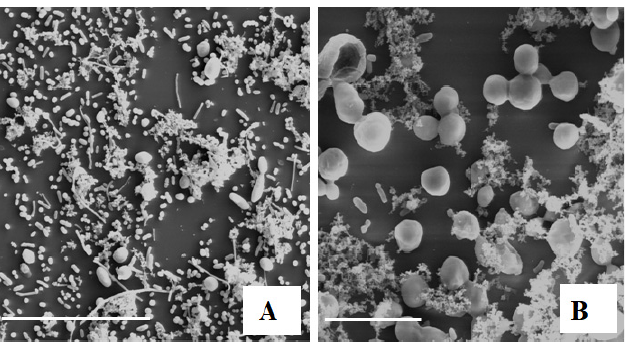
Figure 2. SEM observation of naturally processed black table olive brine with 0% NaCl after one month of incubation in anaerobiosis ( A ) and the presence of slightly pressurized CO 2 ( B ). Bar 30 μ m ( A ) and 10 μ m ( B